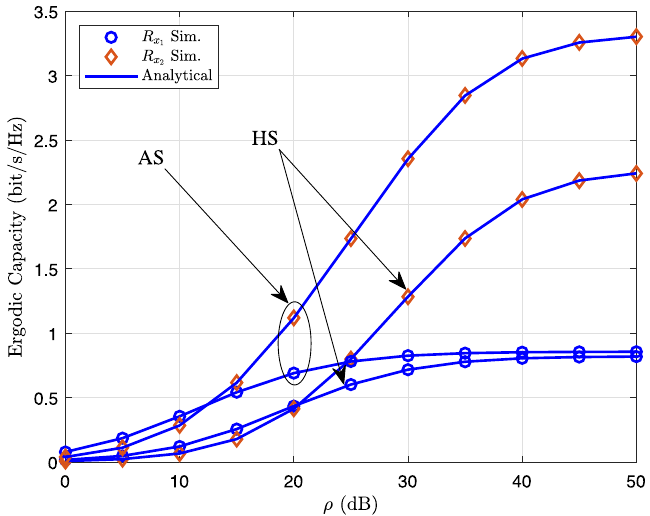
Fig. 6 Ergodic capacity vs ρ (dB) with different satellite